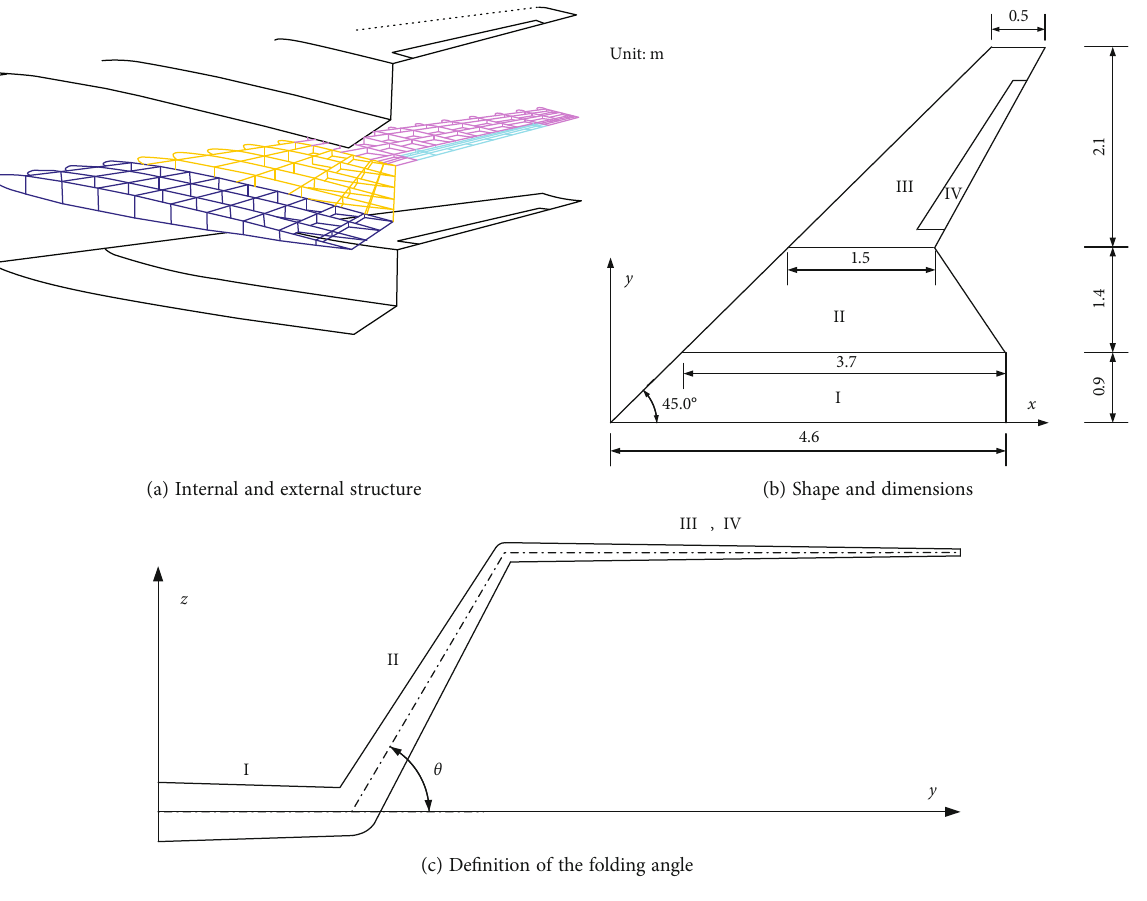
Figure 1: Model of the folding wing. Table 1: Main geometric parameters of unfolding con fi guration. Property Value Mass, m (kg) 823 (m) 2.45, 0.00, 0.00 Center of gravity coordinate, x cg Moment of inertia, I y (kg · m 2 )